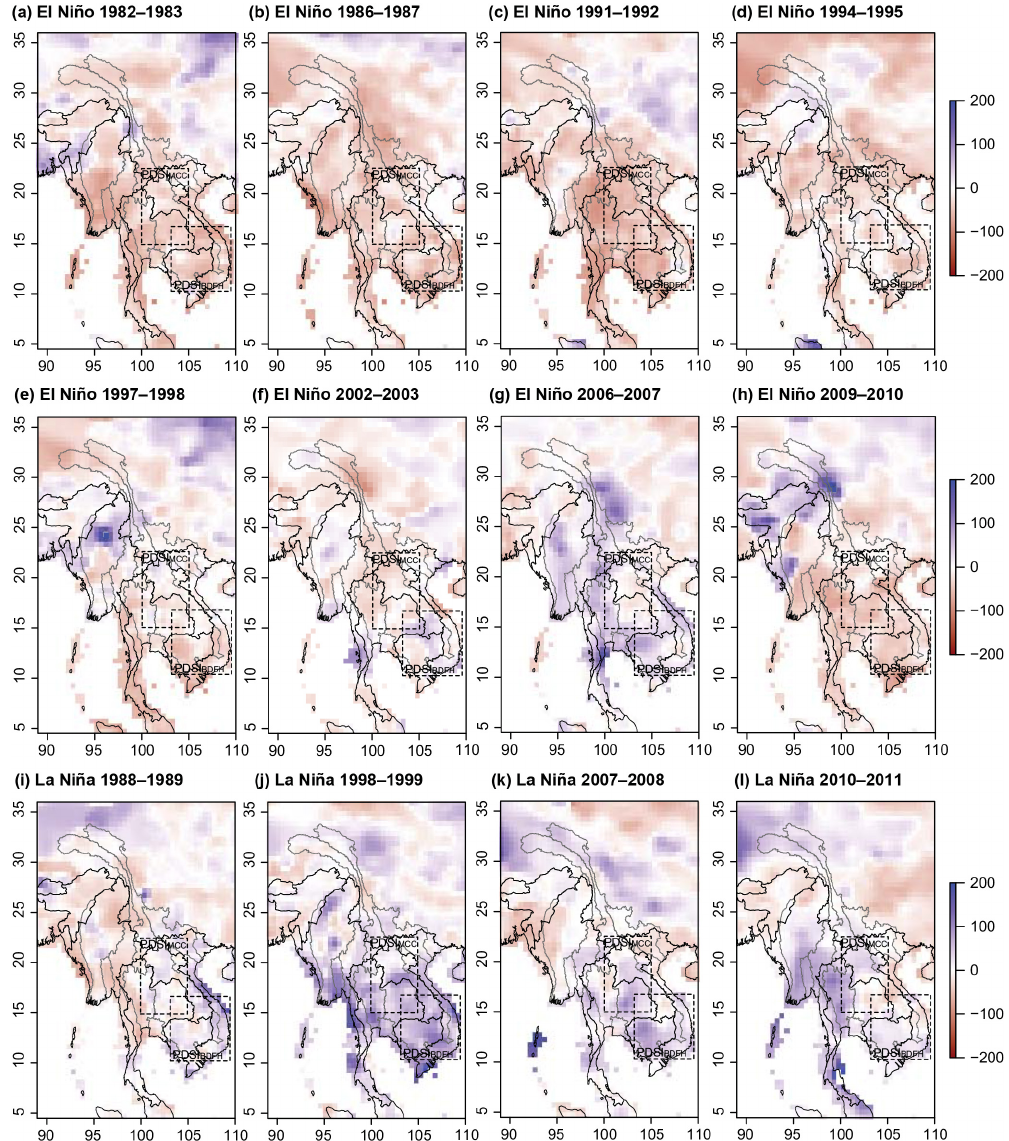
Figure 3. March–May precipitation anomalies (%) during the second year (MAM(1)) of (a–h) eight El Niño and (i–j) four La Niña